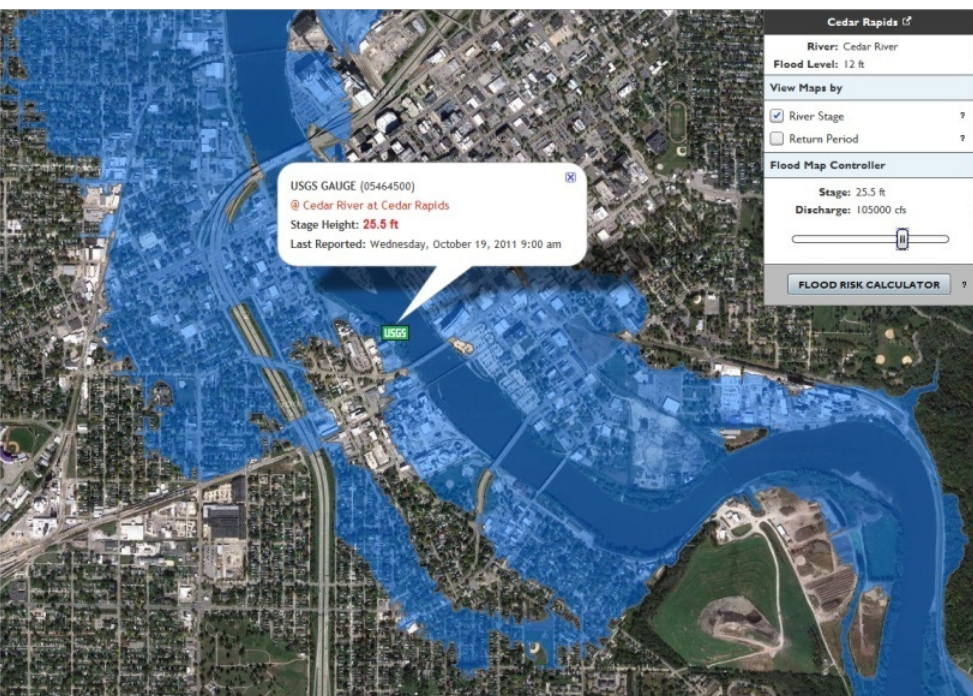
Figure 9 . Example of the detailed urban flood mapping interface available on the Iowa Flood Information System (IFIS). Reported river stage at the gage location is viewable from within the interface. Inundation maps are viewable by river stage or return period using the slider on the